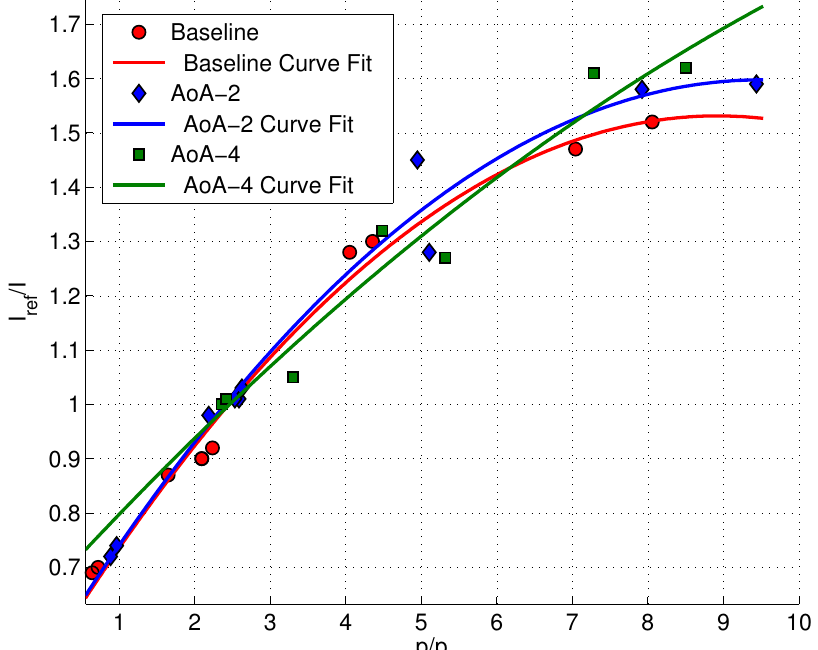
Figure 8. The Stern–Volmer calibration plot for the isolator surface pressure using discreet pressure readings from